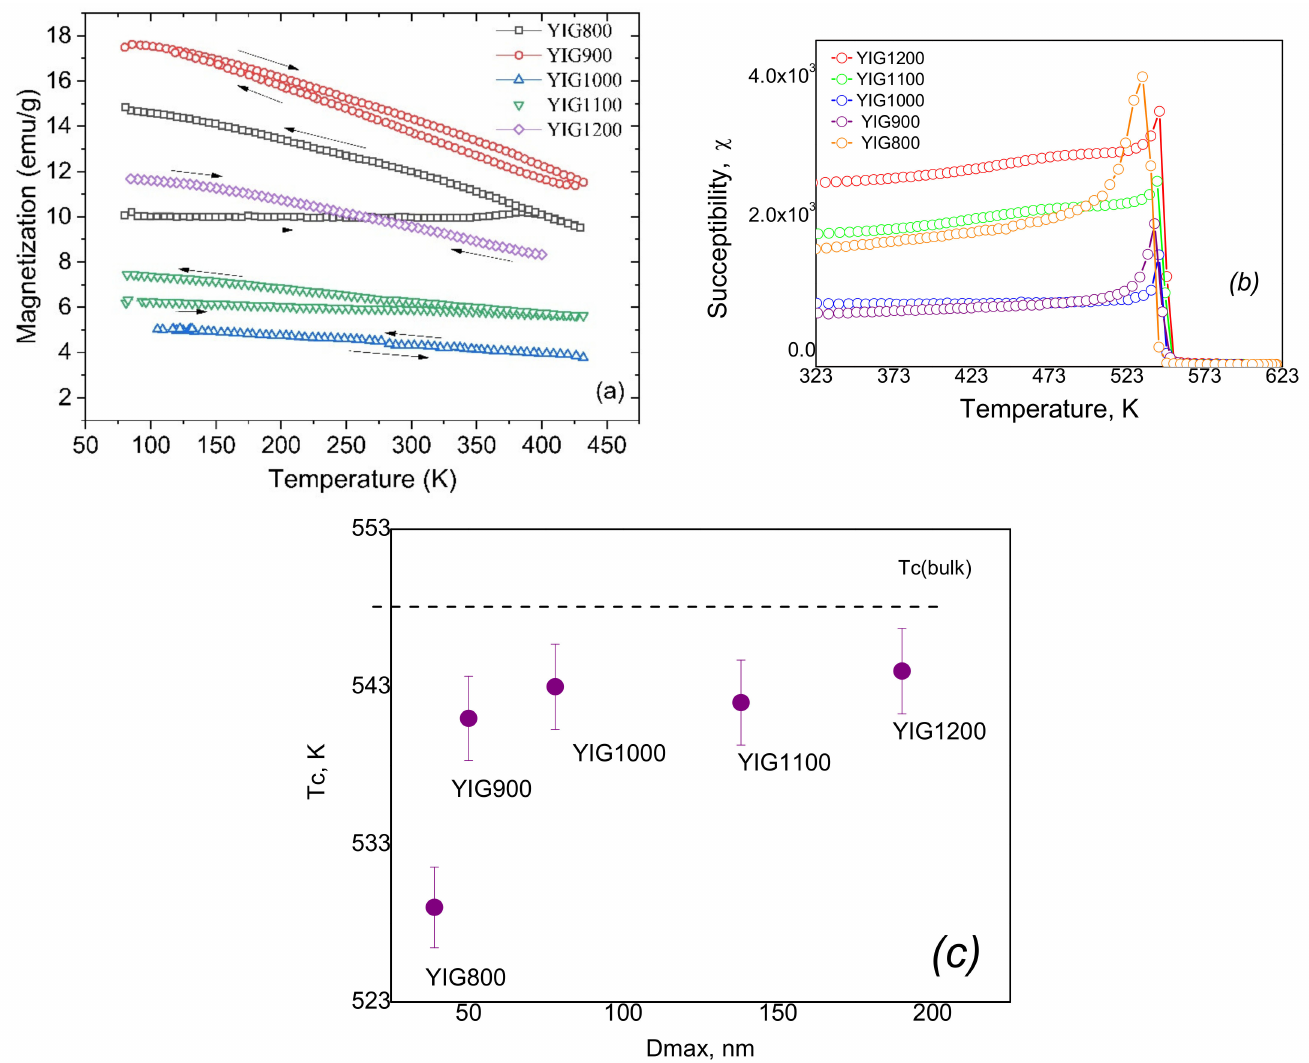
Figure 9. The temperature dependencies of the magnetization in a small field (50 Oe) ( a ), temperature dependencies of susceptibility ( b ), and Curie temperature ( c